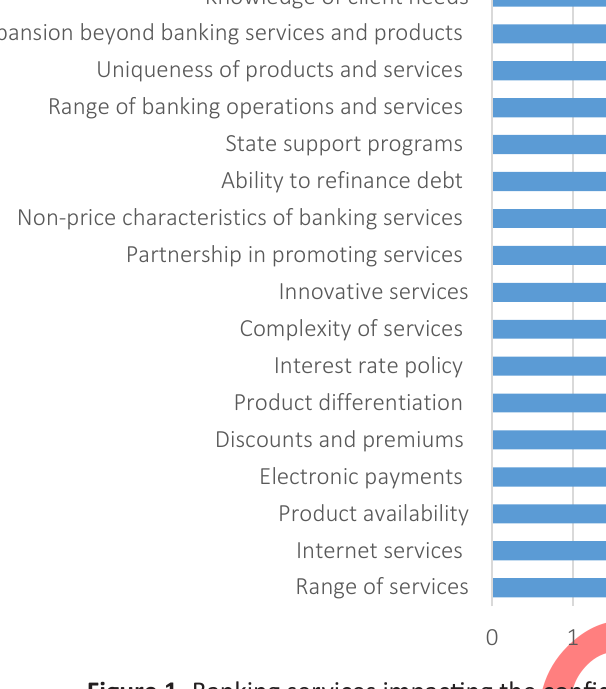
Figure 1. Banking services impacting the confidence level to the Russian banks